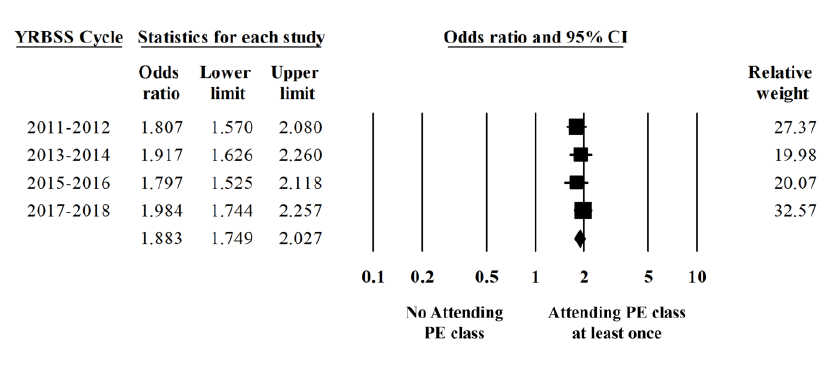
Figure 3. Odds of meeting physical activity guidelines based on participating physical education classes.